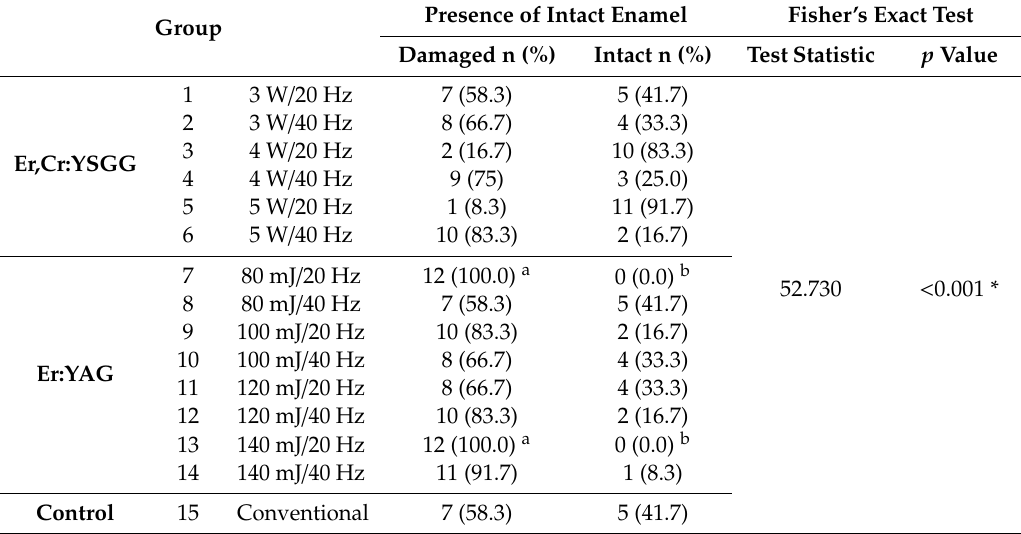
Table 2. Association between the test group and the presence of intact enamel after debonding (n = 180). Presence of Intact Enamel Fisher’s Exact Test Group Damaged n (%) Intact n (%) Test Statistic p Value